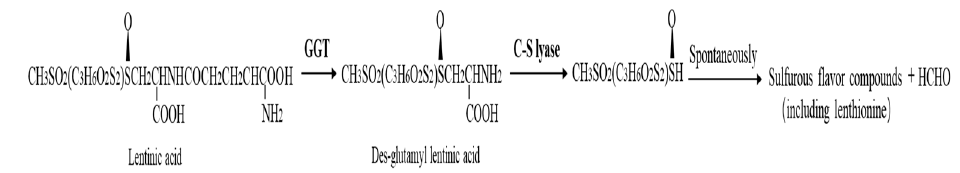
Figure 1. Proposed pathway for the generation of sulfurous flavor compounds and endogenous formaldehyde in Lentinula edodes .